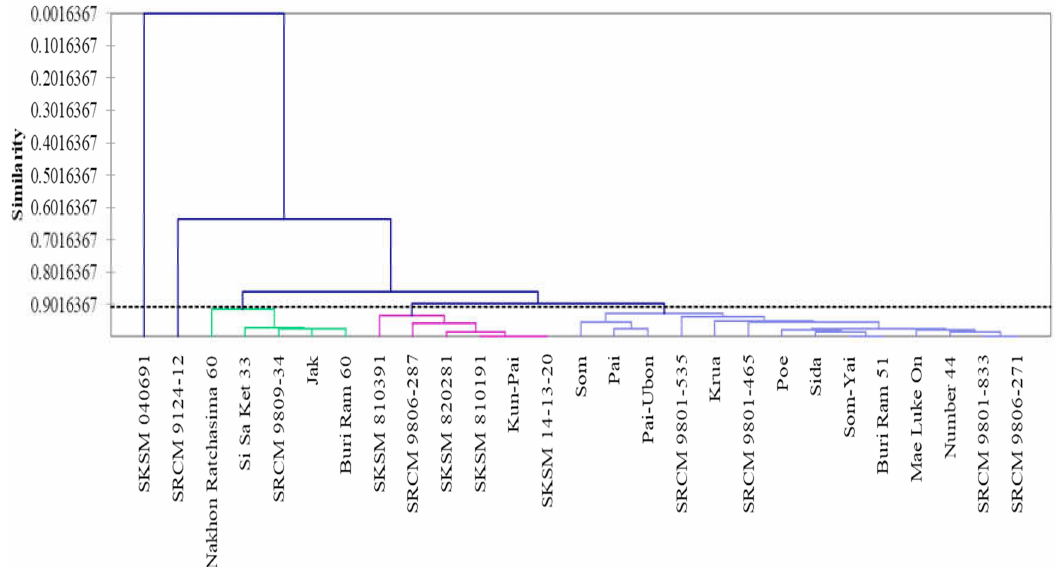
Figure 3. Dendrogram (similarity mode of agglomerative hierarchical clustering analysis) of twenty-seven Morus cultivars by mean value of all